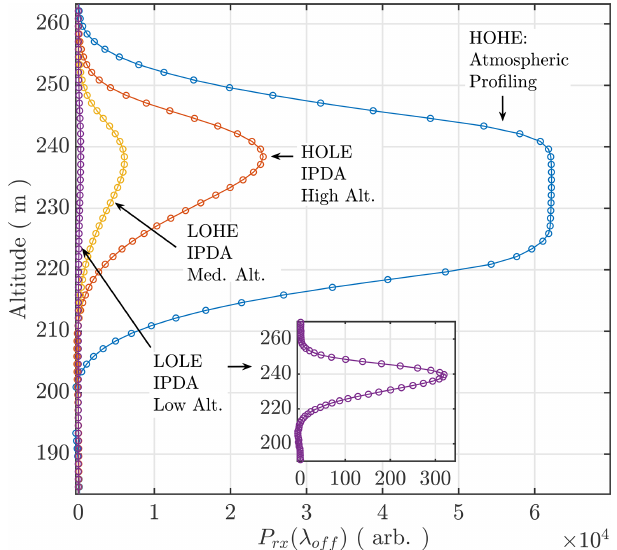
Figure 3. Example of ground return impulse responses for the four IPDA receiver channels for a single 0.5s profile taken from 8km. A single channel maintains high sensitivity for atmospheric backscat- ter. A combination of optical and electrical splits allows for opti- mization of the dynamic range to allow for sampling of the surface return backscatter over a wide range of aircraft altitudes and surface